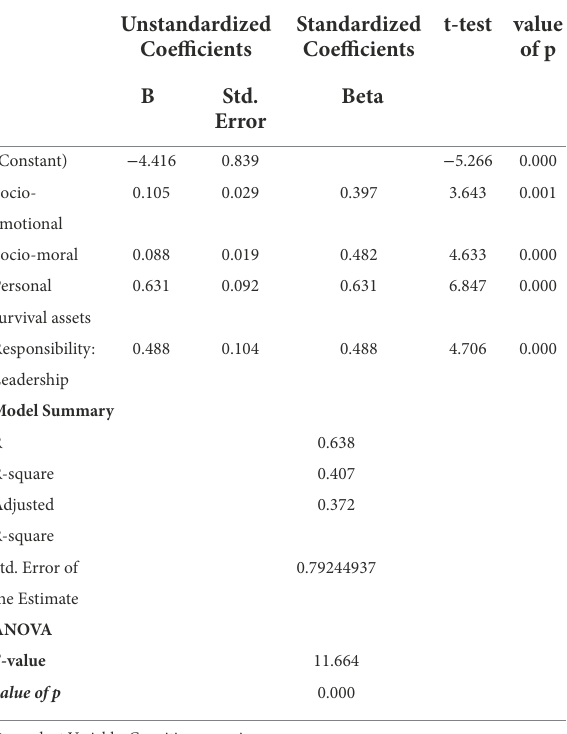
TABLE 4 Regression analysis estimating the effect of resilient cultural practices on cognitive